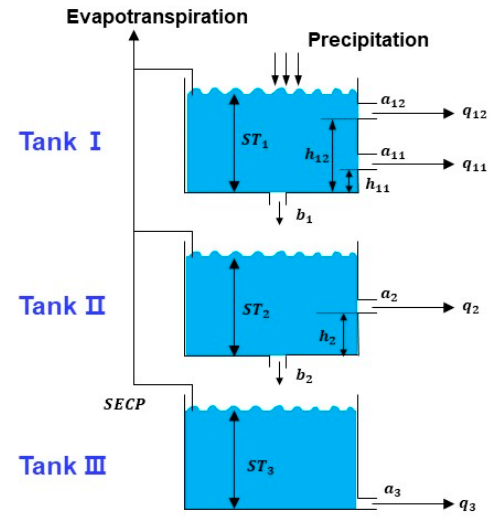
Figure 1. Schematics of the 3-Tank model structures [8,9,36].